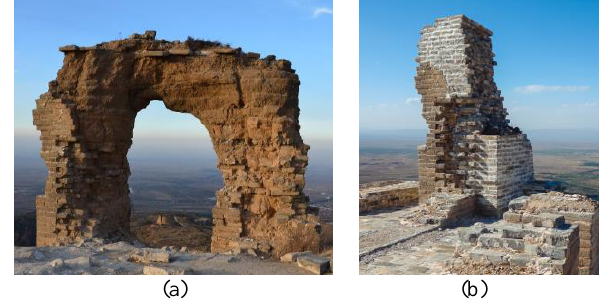
Figure 2. The moon Gate (a) befor collapse;(b) after collapse